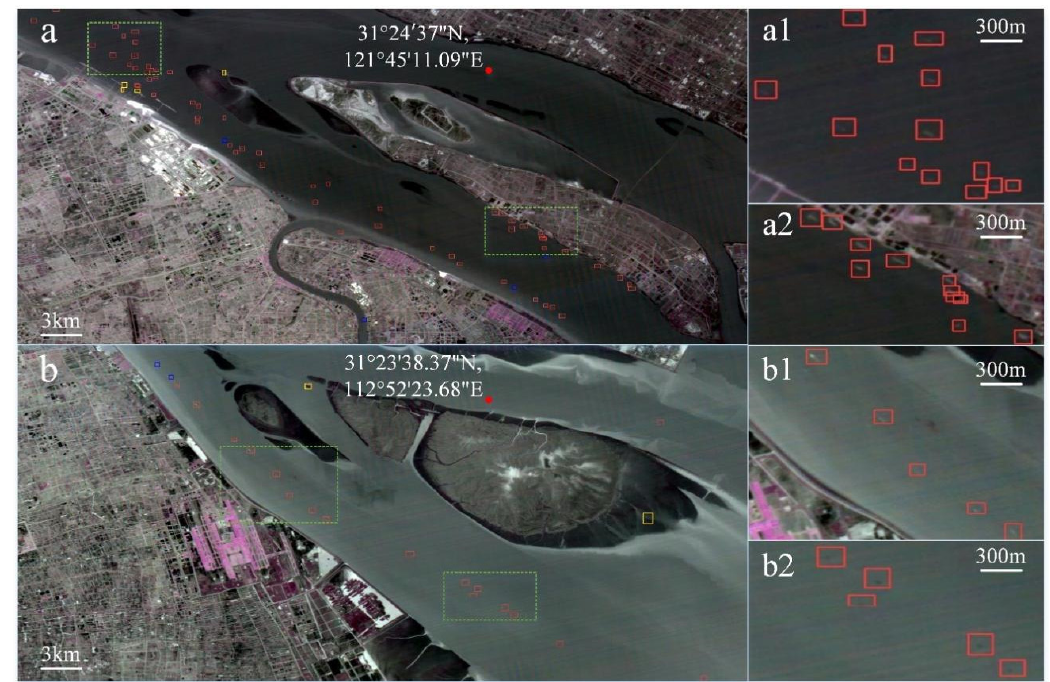
Figure 10. The results of nighttime ship detection by using the TISD in ( a ) Shanghai Port and ( b ) sea near Pudong Airport. (The red boxes show the correct vessel detected, the yellow boxes show false alarms, and the blue boxes show missing alarms).